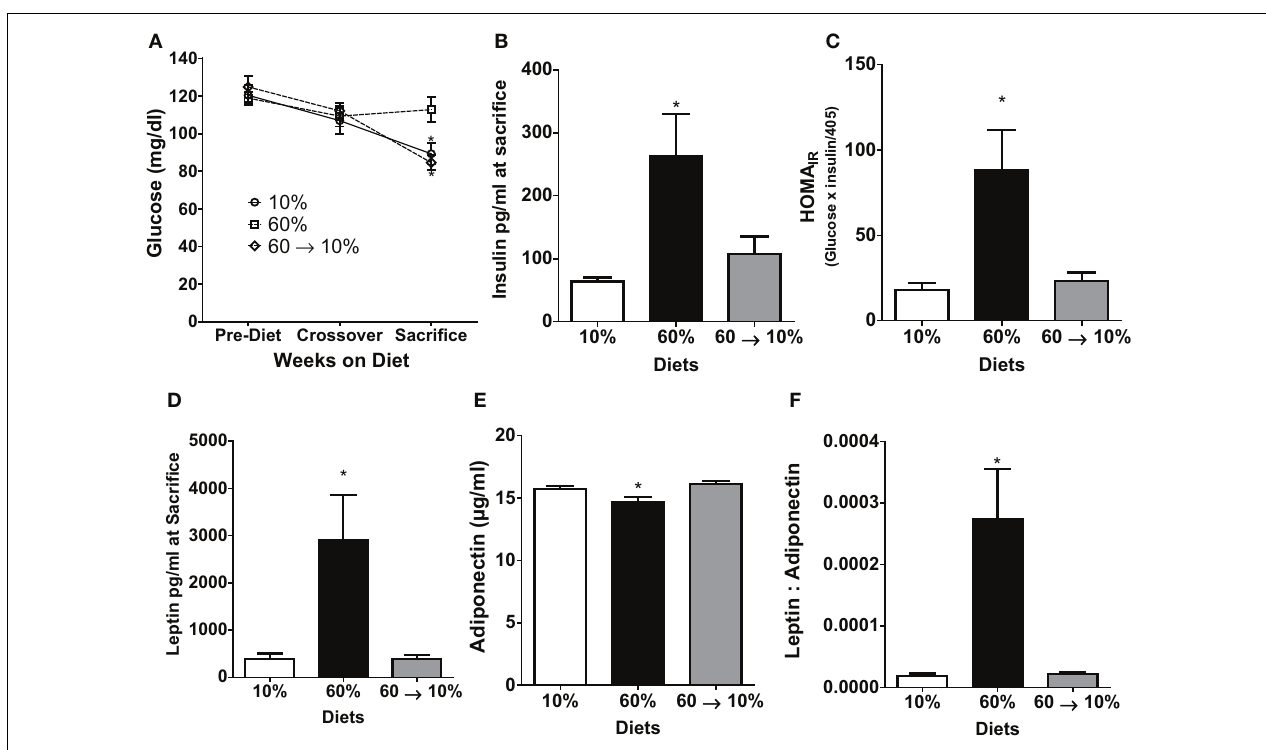
( P = 0.028) and 60 → 10% ( P = 0.013) vs. 60%]. (D) Leptin [* 10% ( P = 0.0157) and 60 → 10%-fed ( P = 0.0155) vs. 60%] and (E) adiponectin [* 10% ( P = 0.0301) and 60 → 10% ( P = 0.0032) vs. 60%] were measured at sacrifice. (F) Leptin: adiponectin ratios [* 10 and 60 → 10%-fed ( P = 0.005) vs. 60%] were calculated from measures at sacrifice. n = 15 mice per diet group for glucose measurements and n = 14 for all other measures including insulin, HOMA IR , leptin, adiponectin, and leptin:adiponectin ratios.